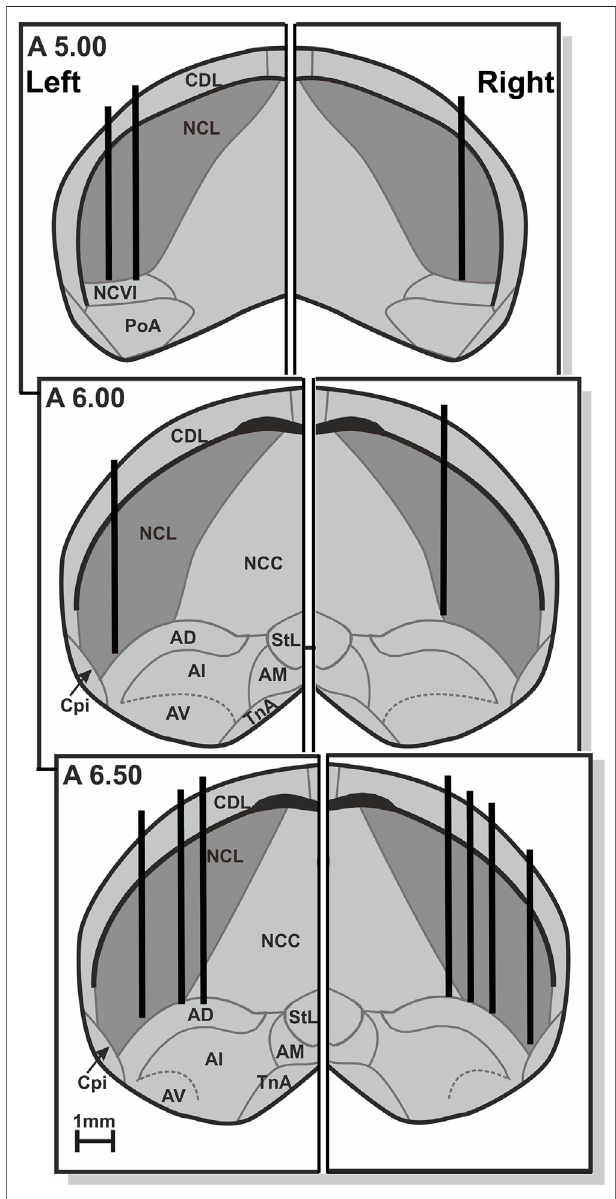
FIGURE 3 | Schematic frontal depiction of the electrode positions in the left and right NCL, based on lesions and electrode tracks. Only the lateral 2/3 of the telencephalon of each hemisphere is shown, and omitting the medial 1/ 3. Abbreviations: AD, arcopallium dorsale; AI, arcopallium